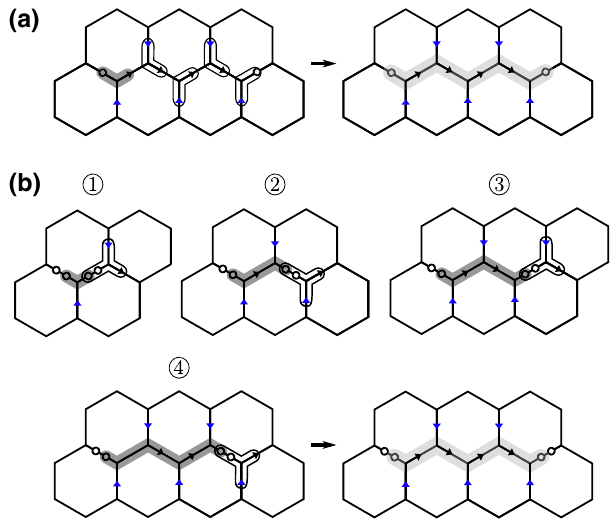
FIG. 9. The decomposed string operators using the move- ments from Fig. 6(b). (a) For the Abelian string operators, an initial short string (dark gray) can be extended to a long string operator (light gray) by a constant-depth local quantum cir- cuit. (b) A sequentially applied quantum circuit is required for extending a short non-Abelian string, resulting in a linear-depth quantum circuit. We show the details of the circuits, including the short string initialization, in Appendix